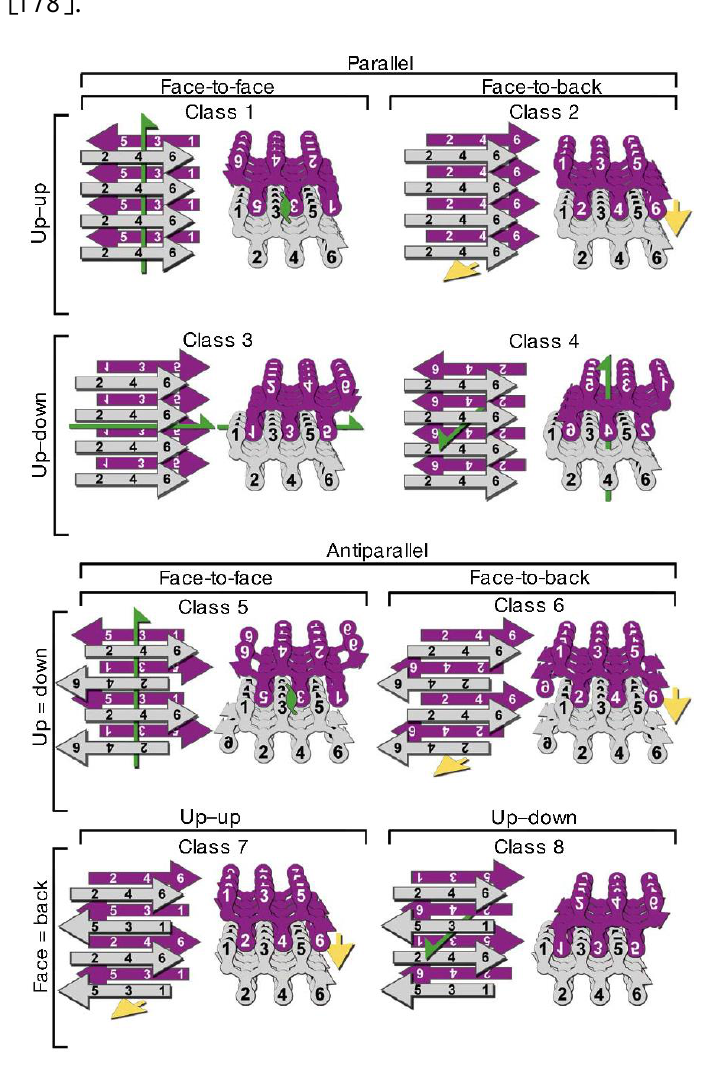
Figure 5. The eight classes of steric zippers (for details see text). Green arrows show two-fold screw axes, and yellow arrows show translational symmetry. Adapted